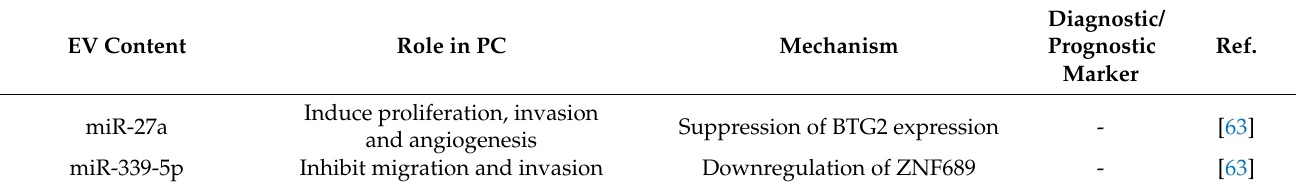
Table 1. Extracellular vesicle (EV) miRNAs, lncRNAs, and proteins in PC.